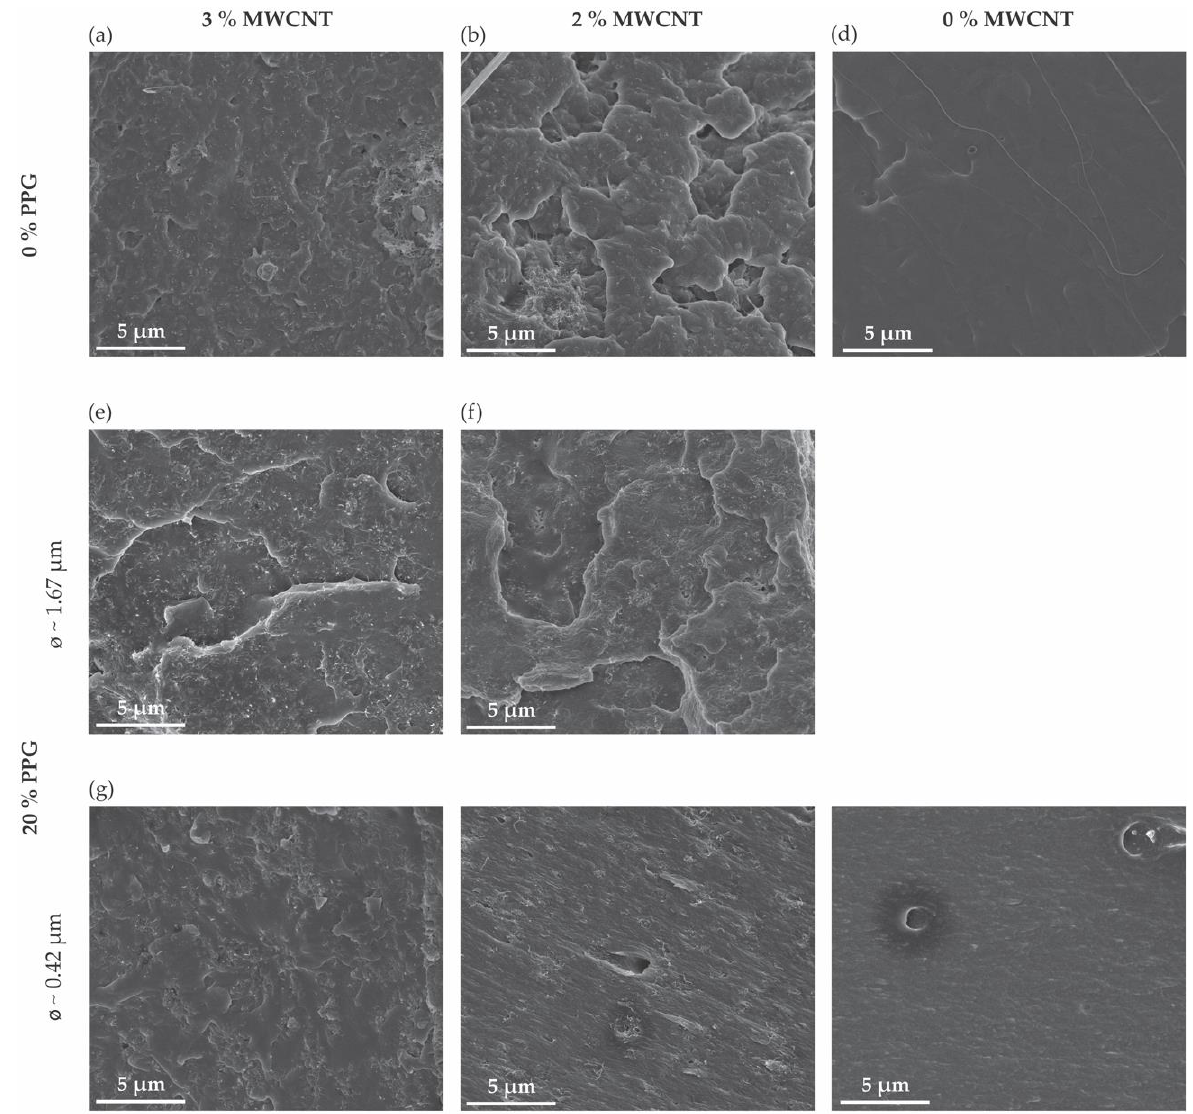
Figure 3. Density plot of MWCNT agglomerate areas. Red lines indicate the quartiles.